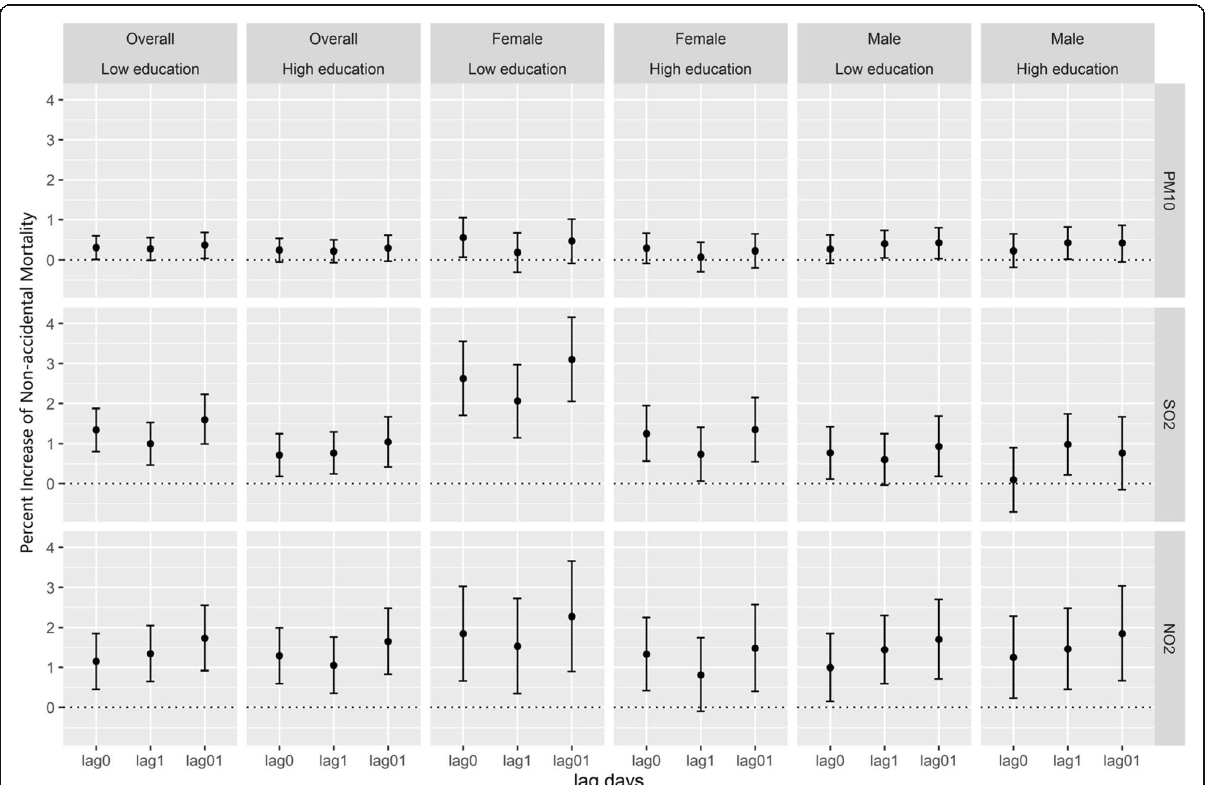
Fig. 3 Effect estimates of education categories and education categories for each sex on non-accidental mortality at lag0, lag1, and lag01 for three